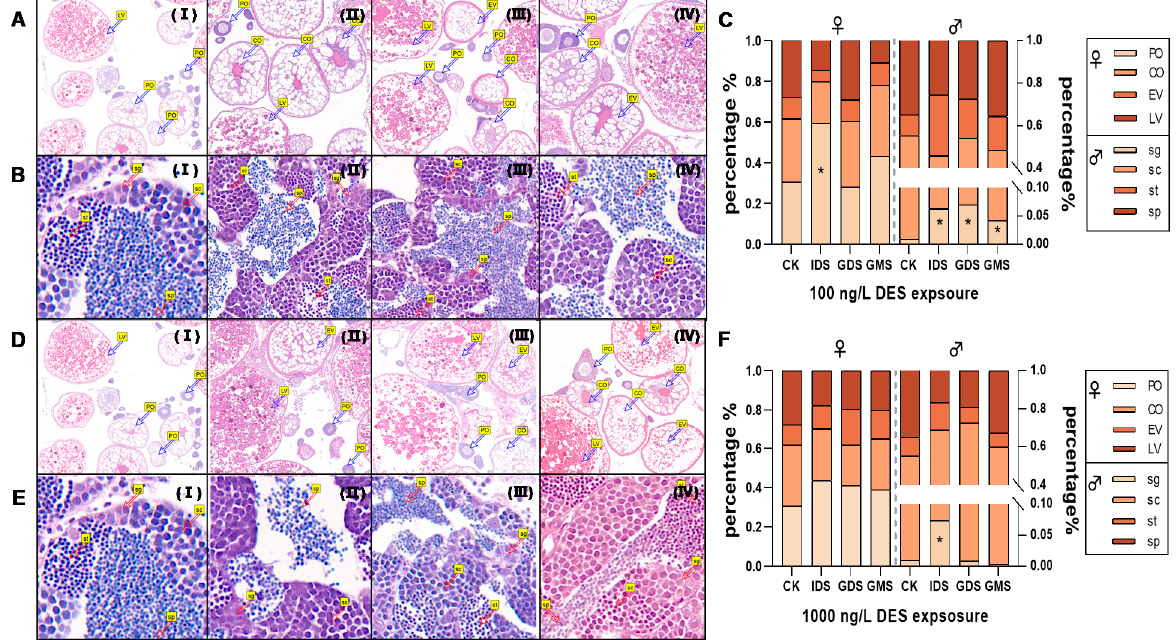
Figure 3. ( A , B ) are tissue slices from zebrafish exposed to 100 ng/L DES, ( D , E ) are tissue slices for 1000 ng/L DES. Ⅰ - Ⅳ stand for different exposure groups (control, IDS, GDS and GMS, respectively). Percentages of egg cells and sperm cells in different development stages in females and males at 90 dpf in ( C ) (100 ng/L) and ( D ) (1000 ng/L), respectively. ( C ) and ( F ) are percentage of eggs cells and sperm cells exposed to 100 ng/L and 1000 ng/L, respectively. Values are shown as mean ( n = 3 replicates per treatment, n = 2 fish per gender of each replicate with 2 cross sections). Asterisks denote significant differences between control and treatments (* p < 0.05, according to Dunnett’s test).LV: late vitellogenesis oocytes; EV: early vitellogenesis oocytes; CO: cortical granular oocytes; PO: perinuclear oocytes; sp: spermatogonia; sc: spermatocytes; st:spermatids; sp: sperm.